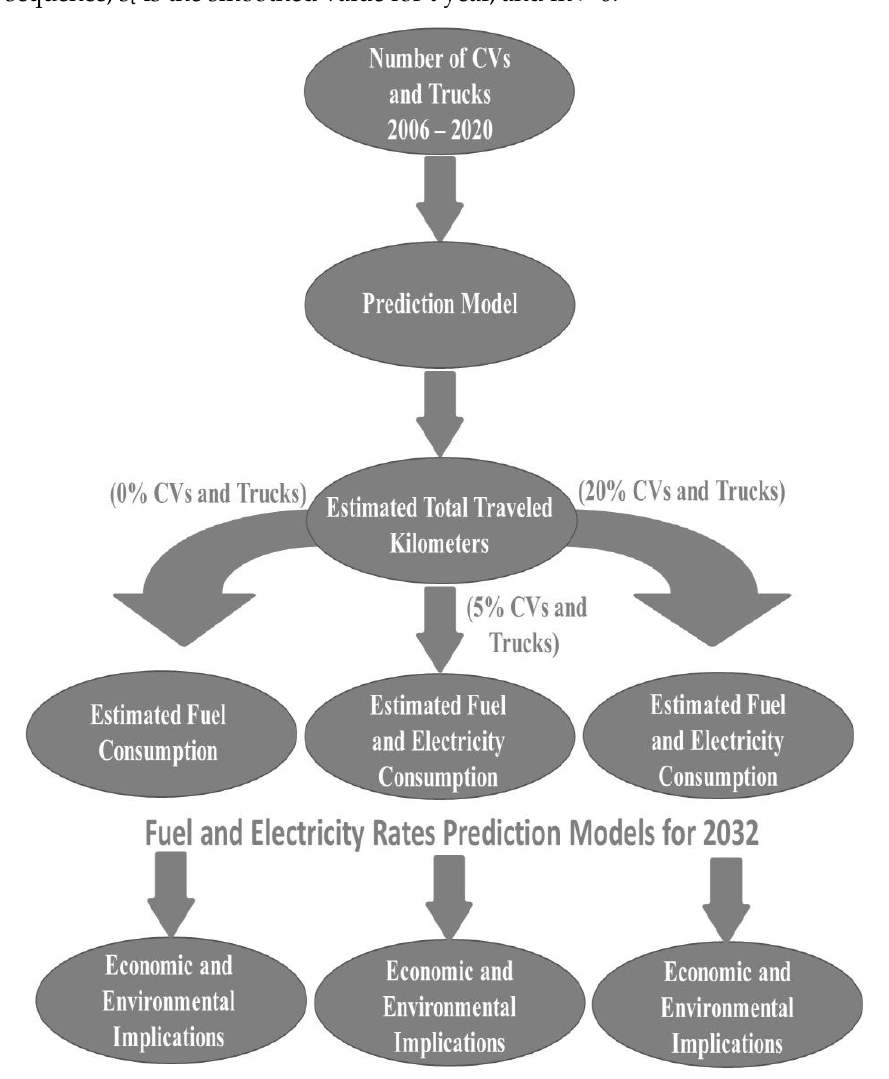
Figure 1. The methodology and processing steps that were applied in this study.